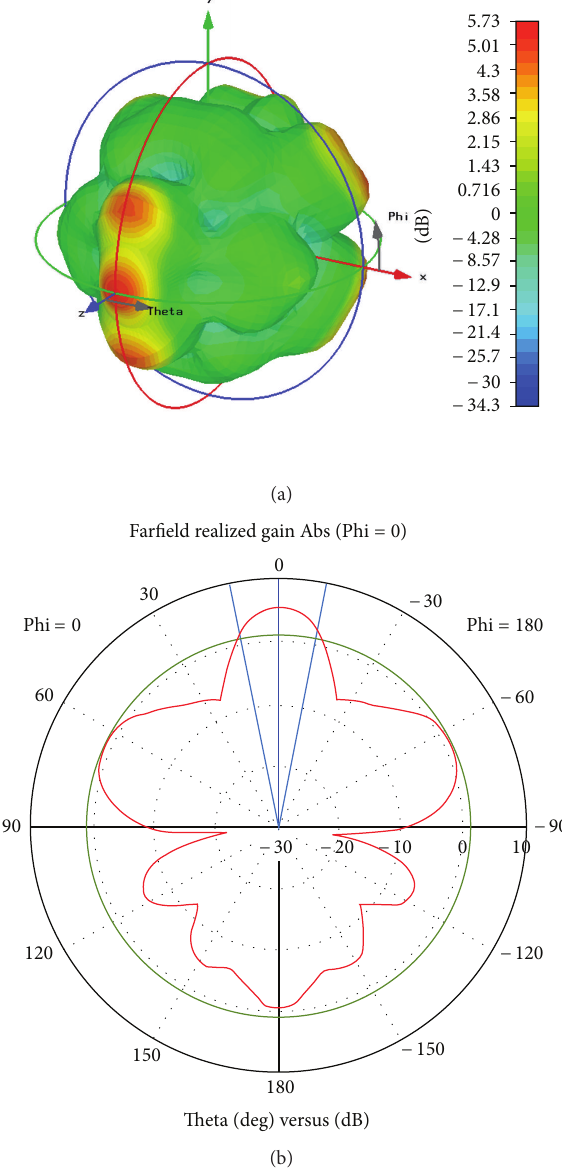
Figure 8: Radiation pattern of bowtie: (a) 3D and (b) 2D elevation cuts for phi = 0 ∘ .